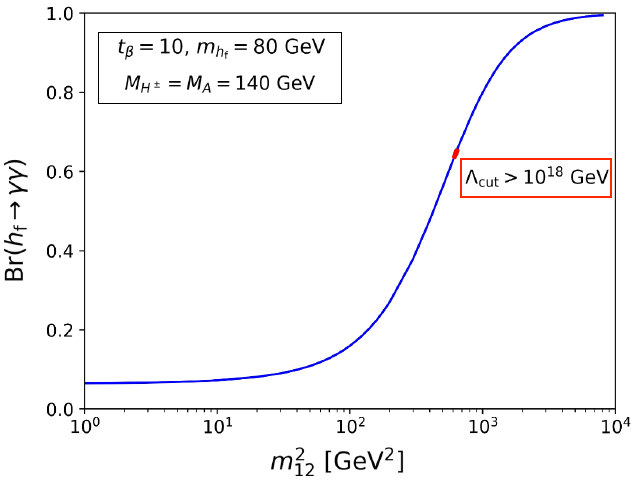
Figure 4 . B ( h f → γγ ) as a function of m 2 The red points correspond to the results of the allowed parameter points with Λ cut > 10 18 GeV